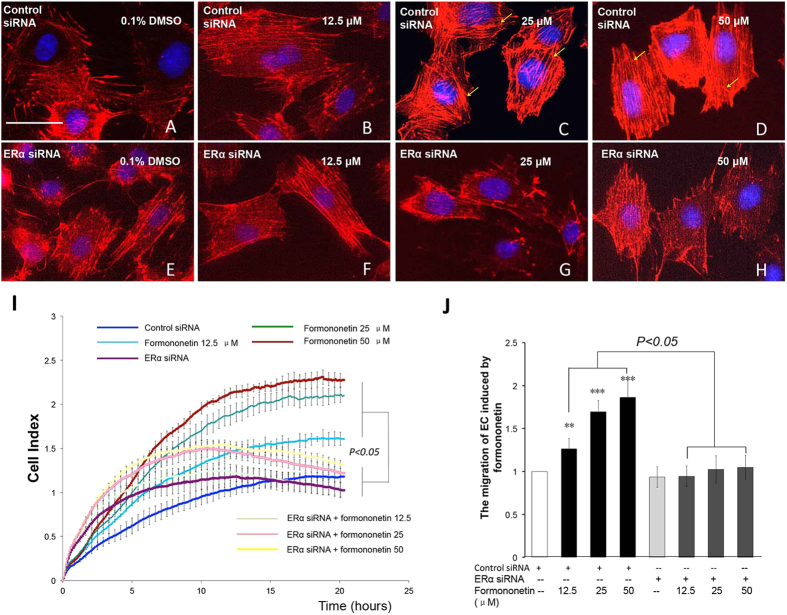
Inhibition of ERα expression by ERα siRNA abolished formononetin-induced stress fiber formation and cell migration in HUVECs.HUVECs were transfected with non-specific siRNA for 2 days followed by (A) 0.1% DMSO, (B) 12.5, (C) 25 and (D) 50 μM formononetin for 8 h to serve as negative control. HUVECs were transfected with ERα siRNA for 2 days followed by (E) 0.1% DMSO, (F) 12.5, (G) 25 and (H) 50 μM formononetin for 8 h. Cell nuclei were labeled with Hochest 33342 and F-actin was labeled with TRITC-phalloidin. Yellow arrowhead indicated stress fibers terminated at pointed edges. (I) Real-time cell migration of HUVECs transfected with ERα siRNA with or without formononetin treatments as detected by the xCELLigence system. HUVECs were transfected with non-specific siRNA or ERα siRNA for 2 days followed by 0.1% DMSO, 12.5, 25 or 50 μM formononetin for 24 h. (G) Statistical analysis of cell migration of HUVECs transfected with ERα siRNA following formononetin treatment for 20 h. Results are expressed as percentages of controls in mean ± SD (n = 3), **p < 0.01, ***p < 0.001 vs. control.